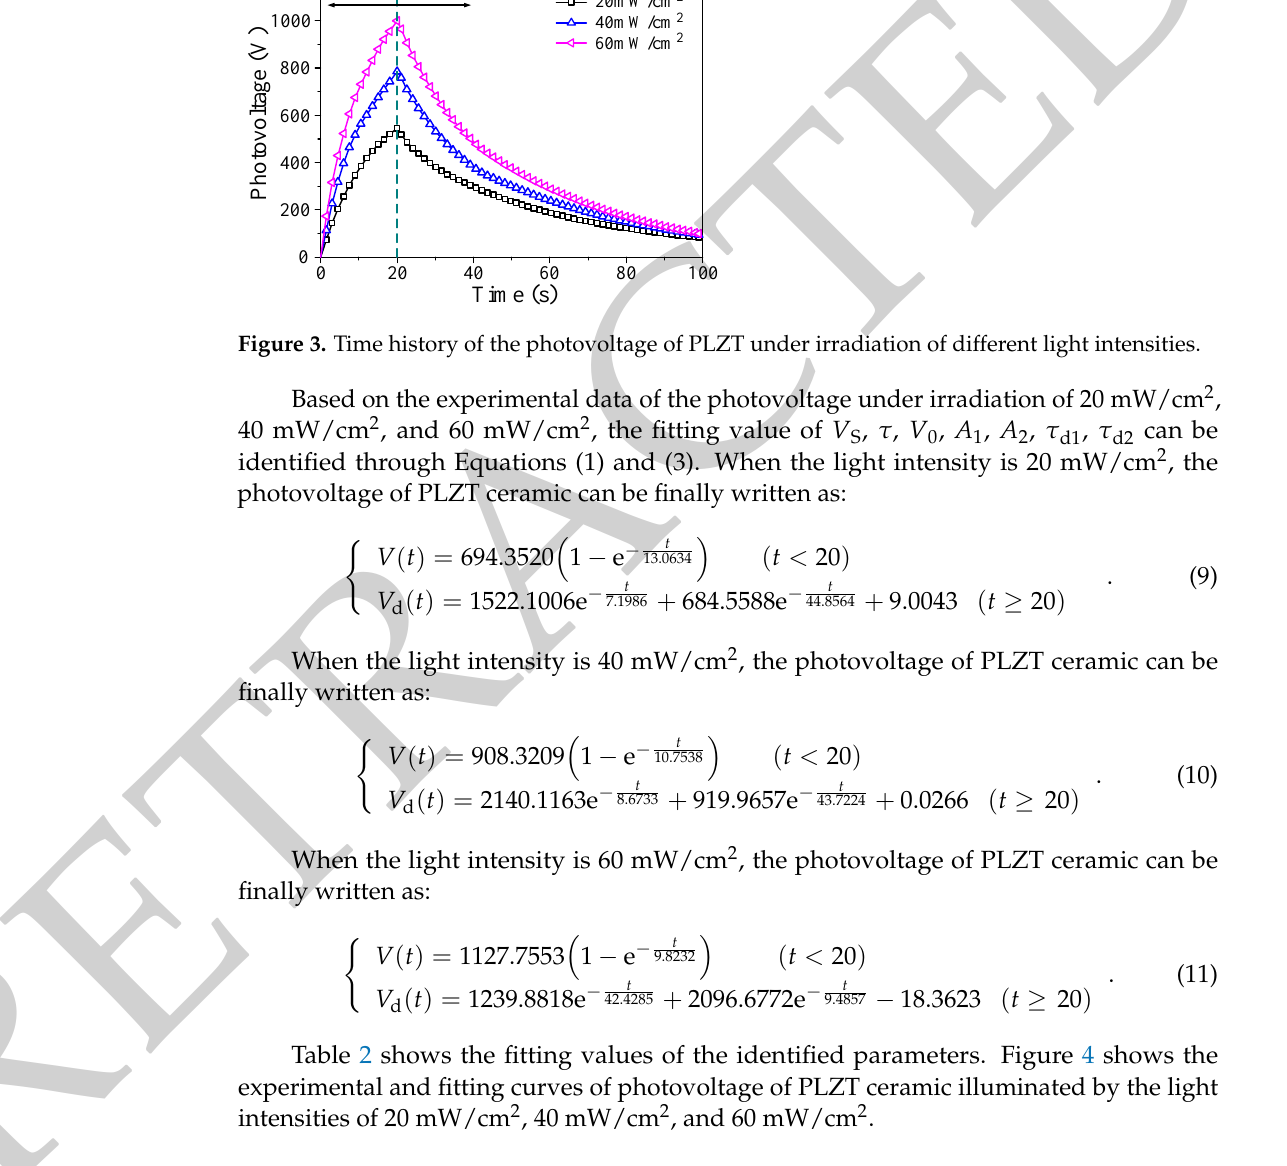
Table 2. The fitting values of the identified